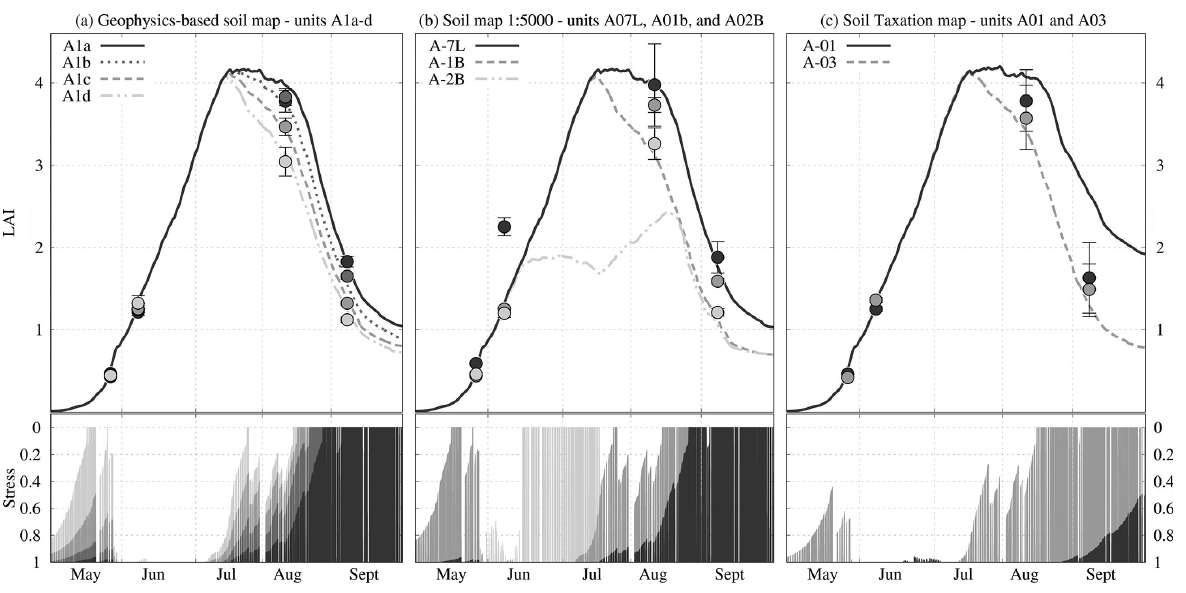
Figure 8. Observed LAI NDVI (dots) of sugar beet compared to the simulated LAI (lines) in sub-area A (upper plots) as well as corresponding stress occurrence (lower plots) simulated using input from (a) the geophysics-based soil map, (b) the 1:5000 soil map, and (c) the soil taxation map.